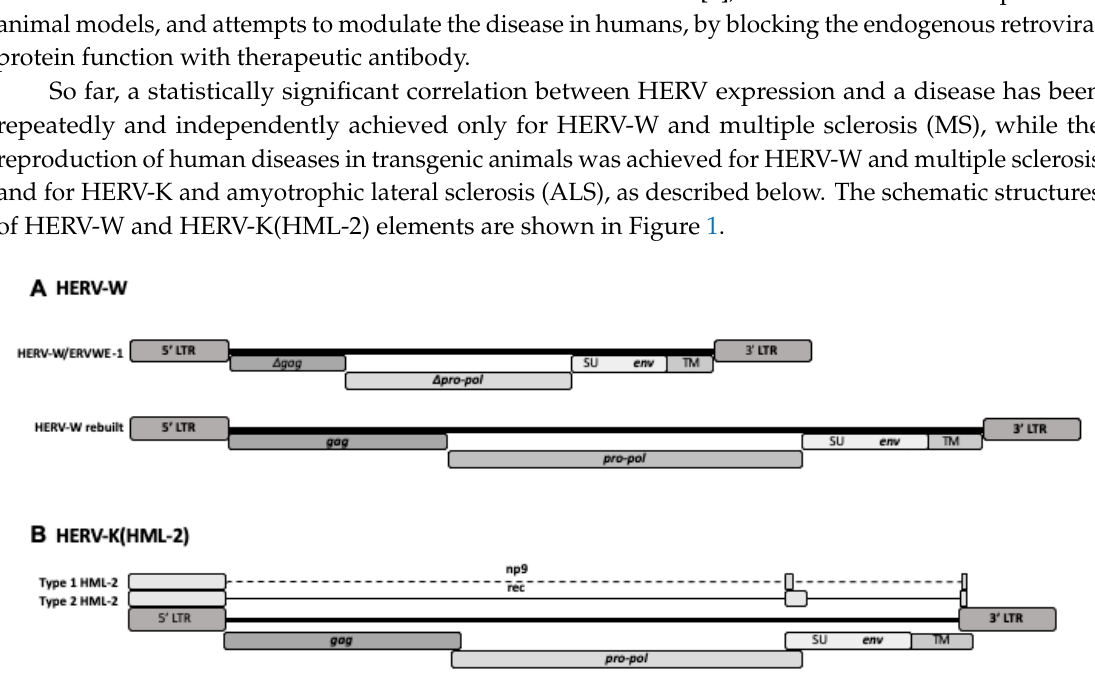
Figure 1. Schematic structure of the human endogenous retrovirus (HERV)-W and HERV-K(HML-2) proviruses in human DNA. Typically, complete proviruses of both families have at the 5 ′ and 3 ′ ends two long terminal repeats (LTRs), which allow and regulate the expression of viral genes, if preserved. Major genes are gag , encoding the capsid proteins; pro-pol , encoding viral protease and reverse transcriptase; env , encoding the envelope proteins. The wide majority of the members of both families are defective. ( A ) The top provirus represents the HERV-W/ERVWE-1 element, located on human chromosome 7q21.22, which retains intact only the env open reading frame, coding for the functional HERV-W/Syncytin-1 protein. The bottom diagram represents the reconstructed HERV-W complete provirus. HERV-W gag, pol, and env proteins from non-localized HERV-W elements have been detected repeatedly [2,3]. The HERV-W family has at least 300 members, not including the solo LTRs [7]. ( B ) The HERV-K(HML-2) subgroup of the HERV-K family. This subgroup has around 60 members with coding capability [8], which are divided in types 1 and 2, by the presence, only in HERV-K(HML-2) type 1, of a 292-bp deletion at the pol-env boundary, which eliminates a splicing site and, instead of Rec, creates the Np9 protein, a pivotal switch of several signaling pathways, which has oncogenic properties. The diagrams are not drawn to scale.